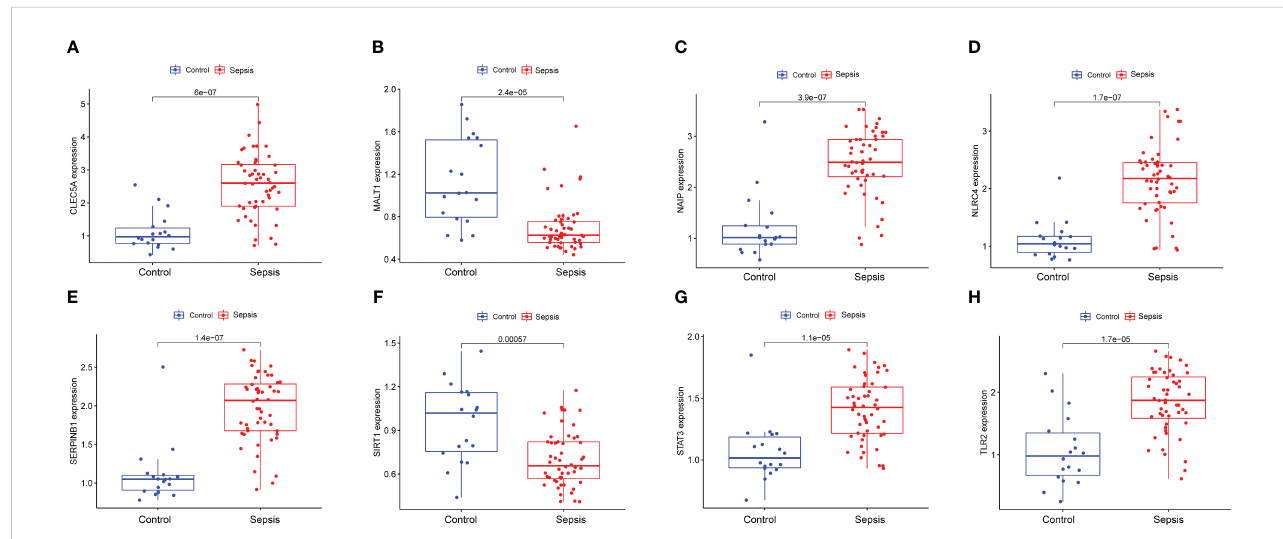
FIGURE 6 Expression of eight diagnostically relevant genes in sepsis patients and healthy controls of CLEC5A (A) , MALT1 (B) , NAIP (C) NLRC4 (D) , SERPINB1 (E) , SIRT1 (F) , STAT3 (G) and TLR2 (H) relative to GAPDH. Median ±